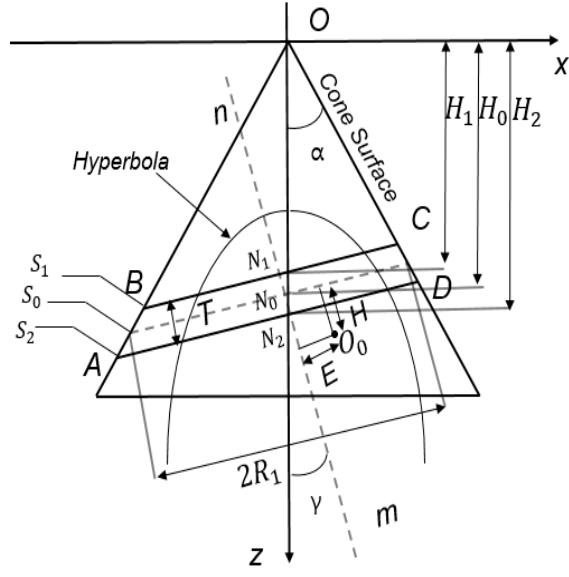
Figure 5. Geometry of triple o ff set seal pair.